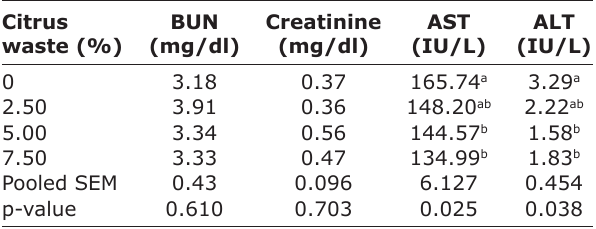
Table -3: Effect of feeding different levels of citrus waste on the liver and kidney function tests in broiler. Citrus BUN (mg/dl) waste (%)